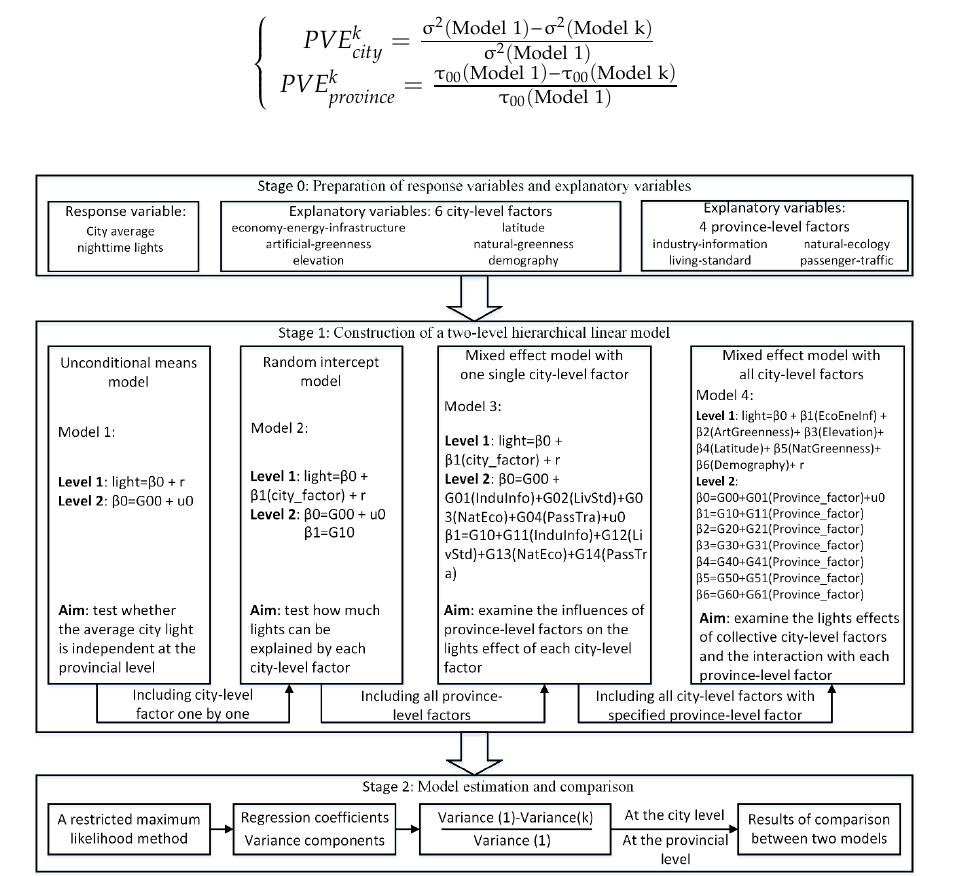
Figure 3. A flowchart for exploring the factors controlling nighttime lights with a hierarchical linear model.